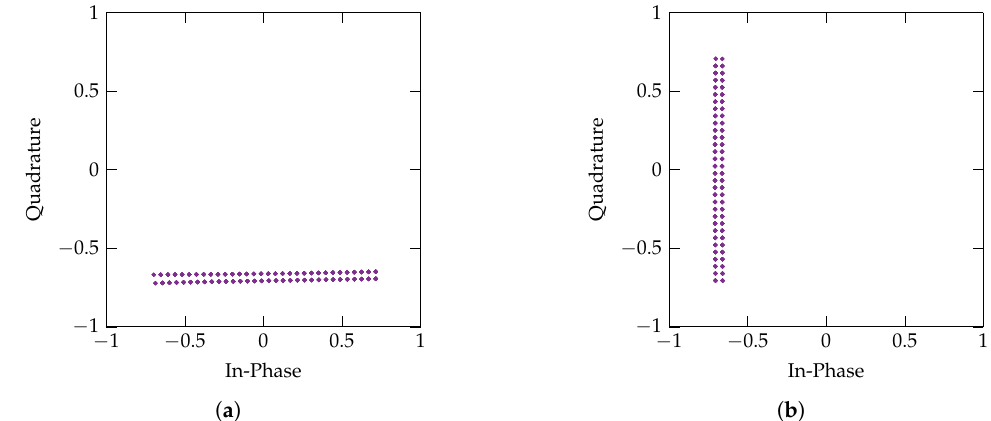
Figure 10. Scatter plots of the first 100 QAM symbols received by the VST during 1024-QAM PLC. ( a ) Carrier frequency of 550 MHz. ( b ) Carrier frequency of 600